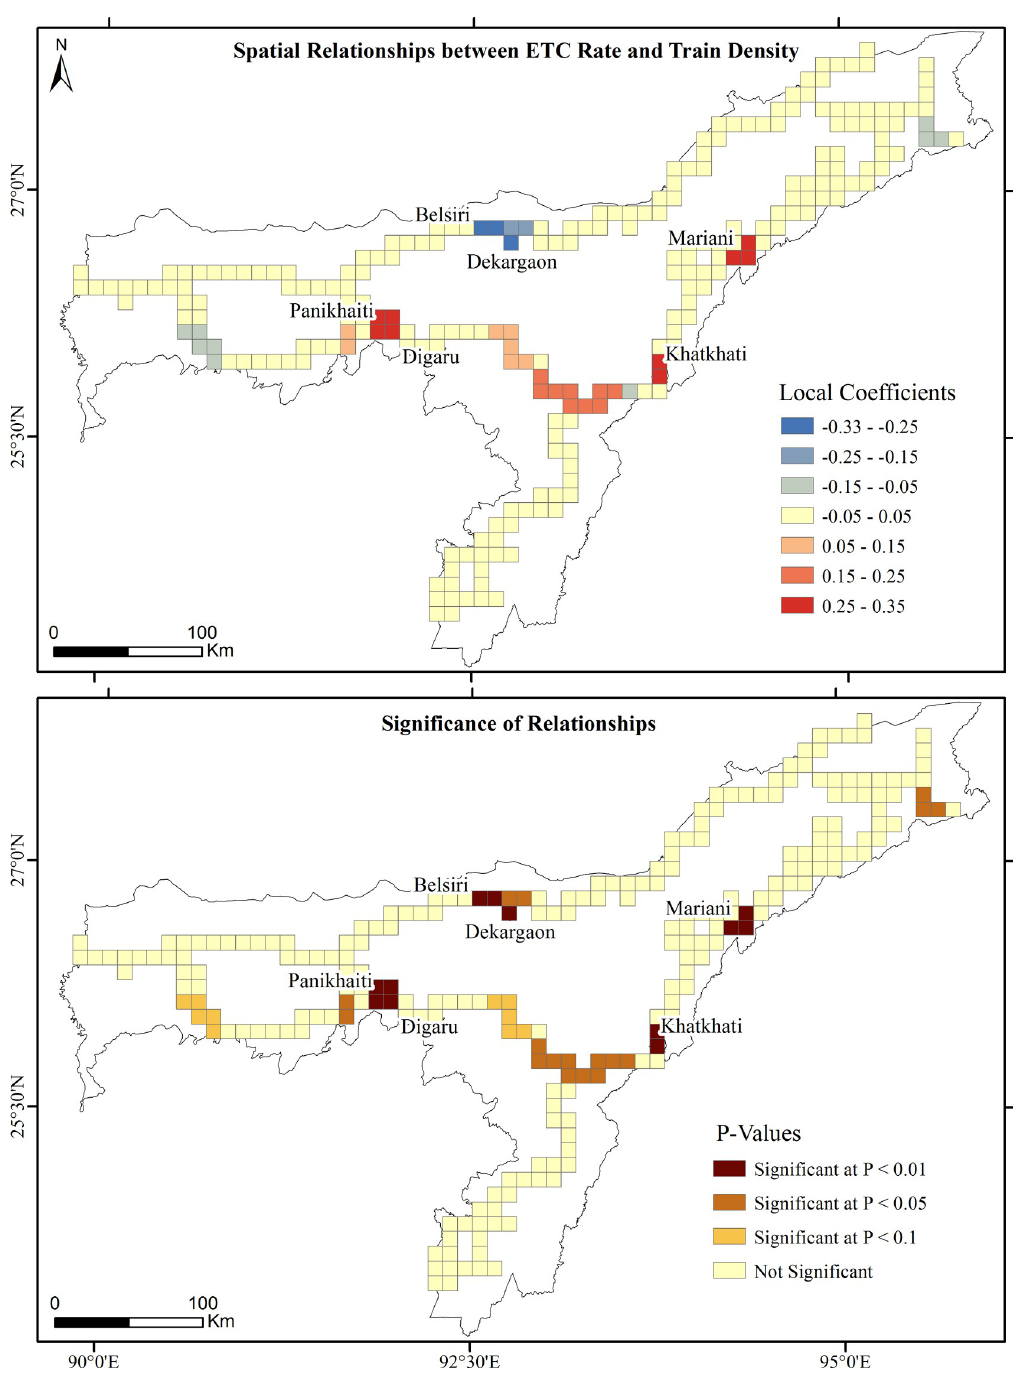
Fig 10. Local coefficients and P-values of GWR model for the spatial relationships between ETC rates and train densities. Conversely, ETC rates increased with decreased elephant density in the Habaipur-Diphu railroad. These inconsistent results suggest that decreasing elephant density do not necessarily reduce the frequency of elephant railroad-crossings [84]. Elephants usually follow the migra- tory paths of their ancestors, notwithstanding the anthropogenic disturbances prevailing in